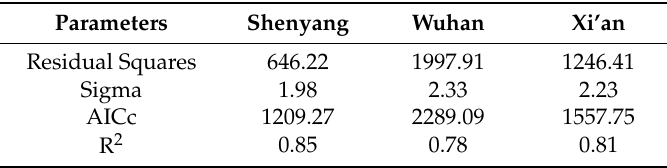
Table 2. Results of the GWR model.